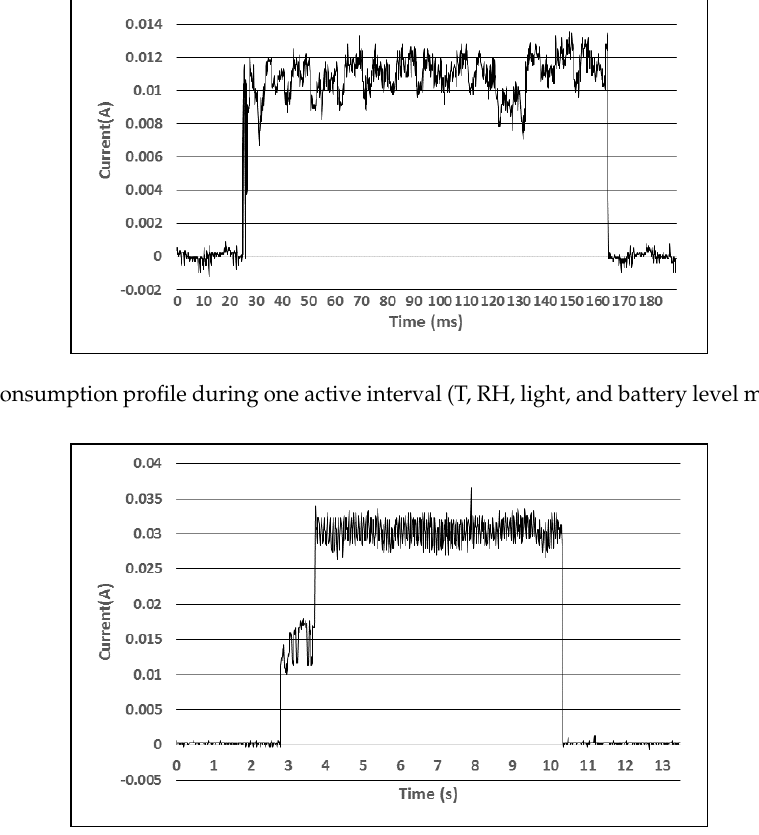
Figure 6. Consumption profile during one active interval (T, RH, light, battery level, and air quality parameters measurement).